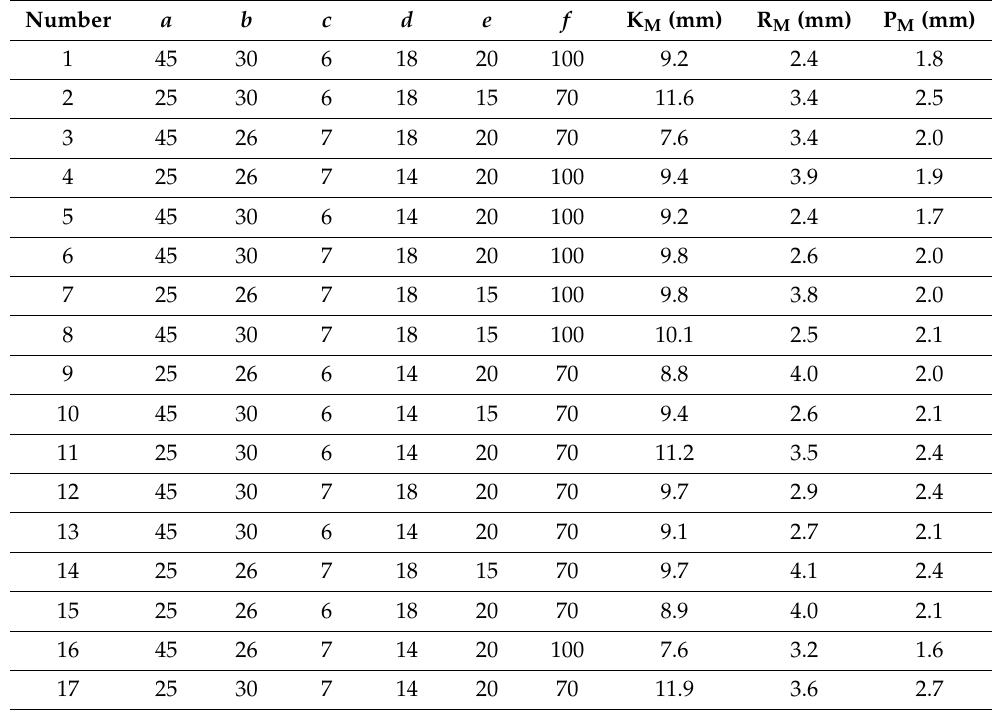
Table 4. Experimental design and weld bead size for MIG